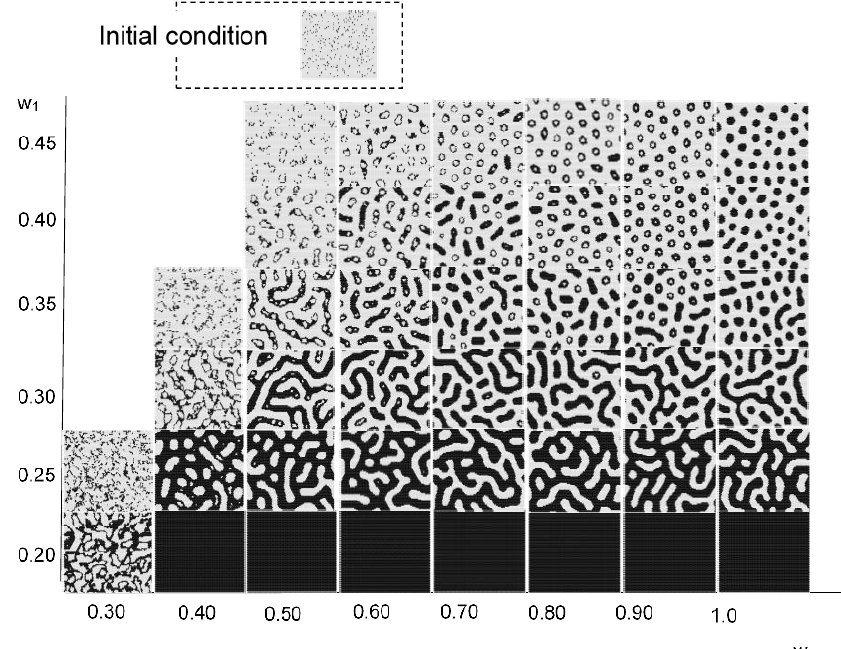
Figure 8. Results for the model with s = 5 and t = 9 in a hexagonal grid. The results image of each w 1 and w 2 value is based on 300 randomly arranged state 1 cells. Instability became stronger as w 2 decreased to w 1 .